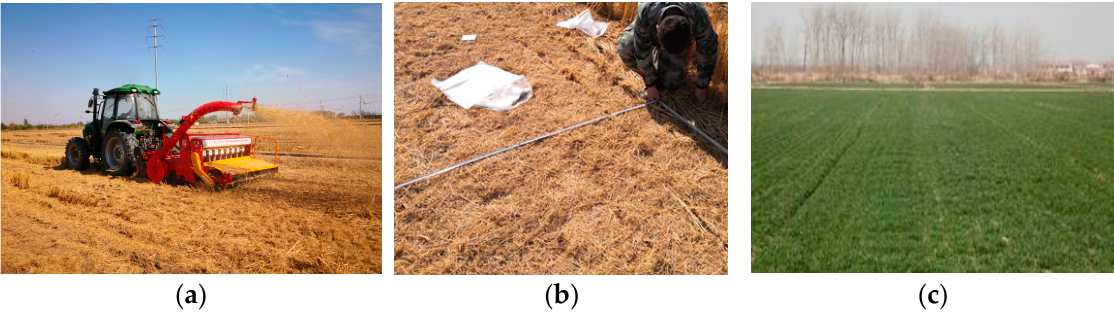
Figure 16. Field experiment. ( a ) Field test; ( b ) Dividing survey area; ( c ) Crop growth tracking.